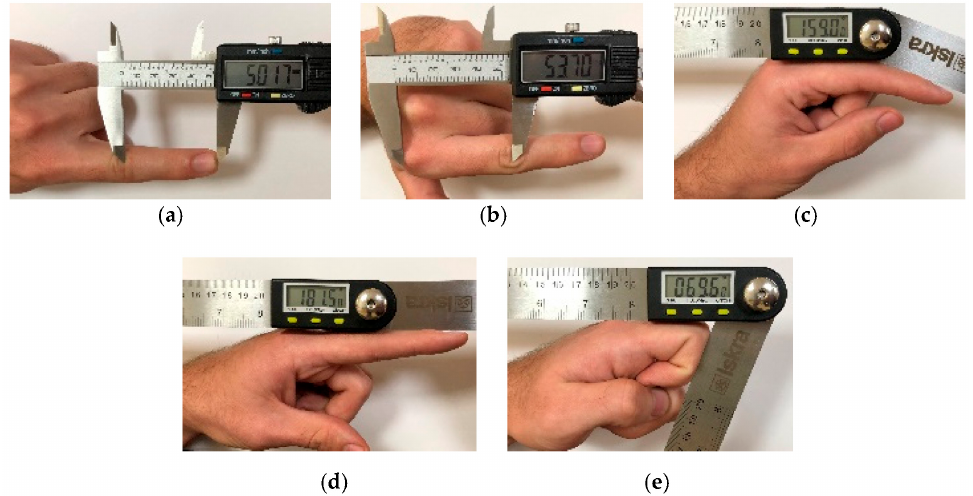
Figure 4. Measurements of the index finger: ( a ) Combined length of distal and intermediate phalanges bone and ( b ) Length of proximal phalanges bone. The angle of the PIP joint in: ( c ) A resting position, ( d ) Hyperextension, and ( e ) Flexion.